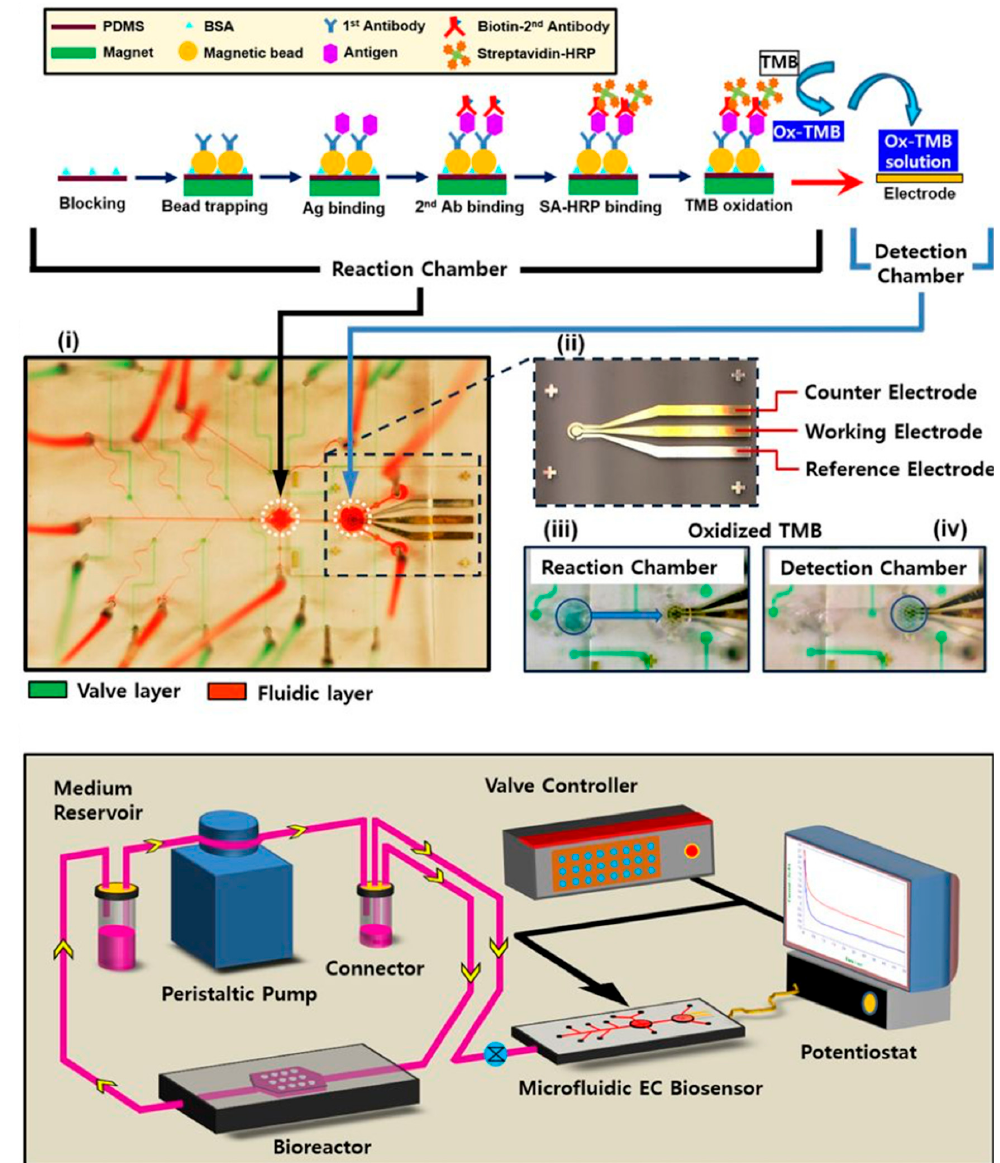
Figure 7. Immunosensing principle with the EC sensor for detection of target biomarkers and fabricated microfluidic sensing chip, ( i ) photograph ( ii ) microelectrodes, ( iii ) reaction chamber with oxidized TMB, ( iv ) transfer of oxidized TMB to the detection chamber and microfluidic sensing system. Bovine serum albumin (BSA); Horseradish peroxidase (HRP); Tetramethylbenzidine (TMB) (Reproduced from